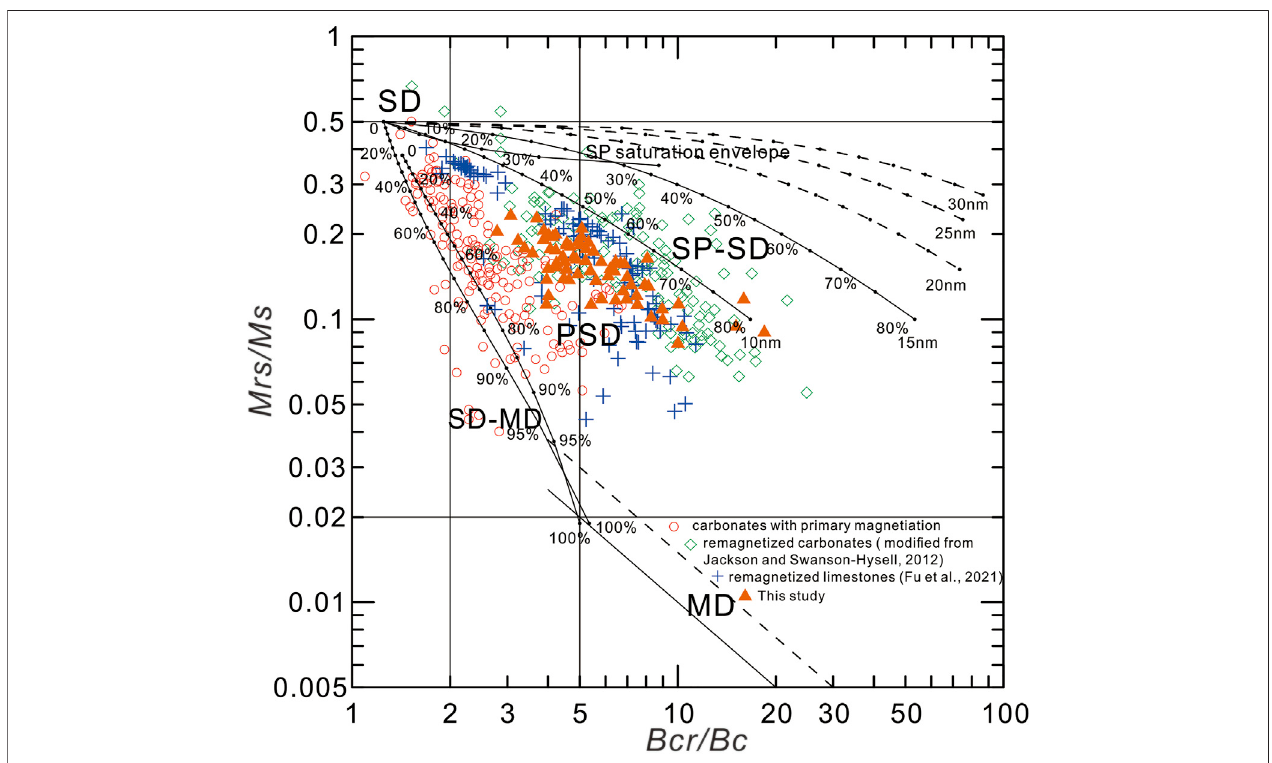
FIGURE 7 | Day plot of 69 limestone samples. Also, published hysteresis parameters are plotted for remagnetized and non-remagnetized carbonate rocks summarized by Jackson and Swanson-Hysell (2012) and Fu et al. (2021). Green diamonds and blue cross (red circles) denote remagnetized (non-remagnetized)